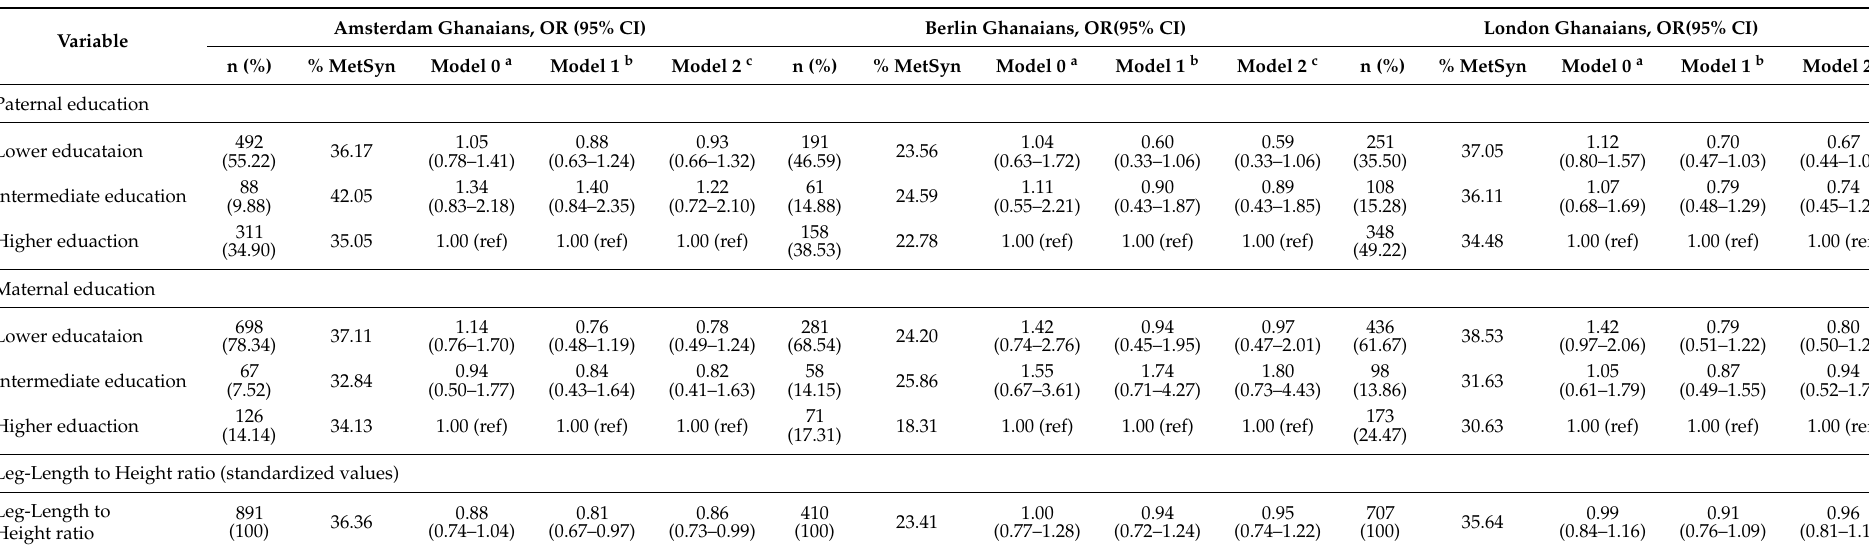
Table A1. Associations between Early Life Factors and Metabolic Syndrome among Migrant Ghanaians Stratified by Site in Europe.